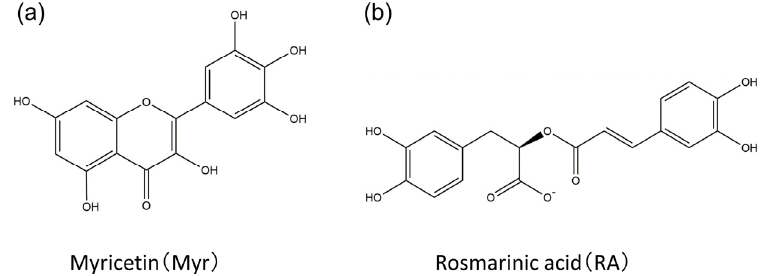
Figure 9. Chemical structures of the ( a ) myricetin (Myr) and ( b ) rosmarinic acid (RA). Reprinted with permission from Reference [26]. Copyright 2020 Elsevier.